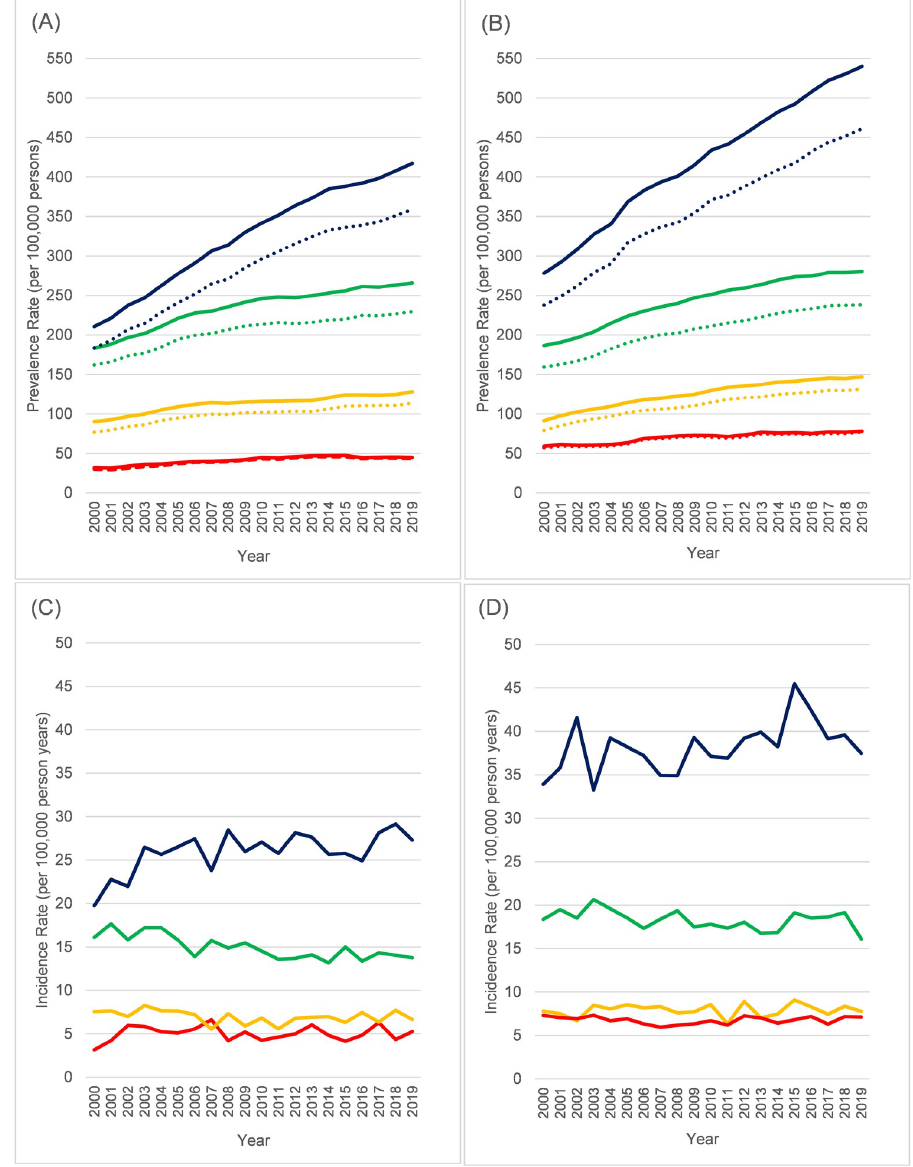
Fig 3. Prevalence and incidence rates (per 100,000 persons) in neuromuscular disease 2000–2019 by age. (A) Prevalence in females. (B) Prevalence in males. (C) Incidence in females. (D) Incidence in males. Red = 0–14 years. Orange = 15–44 years. Green = 45–64 years. Blue = 65+ years. For prevalence, Solid lines = Lifetime, Dotted lines = excluding Guillain-Barre´ syndrome codes not recorded in last 5 years. All rates age standardised (within age- group) to CPRD population as of